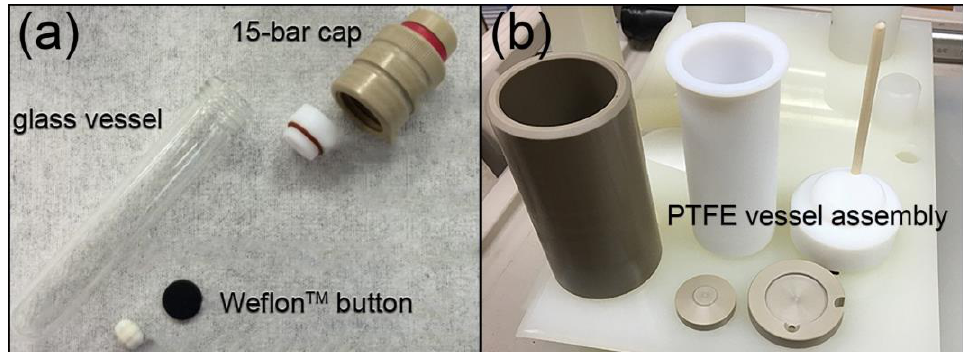
Figure 3. MW-transparent reaction vessel assemblies: ( a ) glass reaction vessel with pressure-responsive cap and graphite-doped Teflon (WeflonTM) button as MW susceptor; ( b ) solvothermal PTFE control vessel with thermowell for fiber optic temperature sensor. All equipment supplied by Milestone Srl.